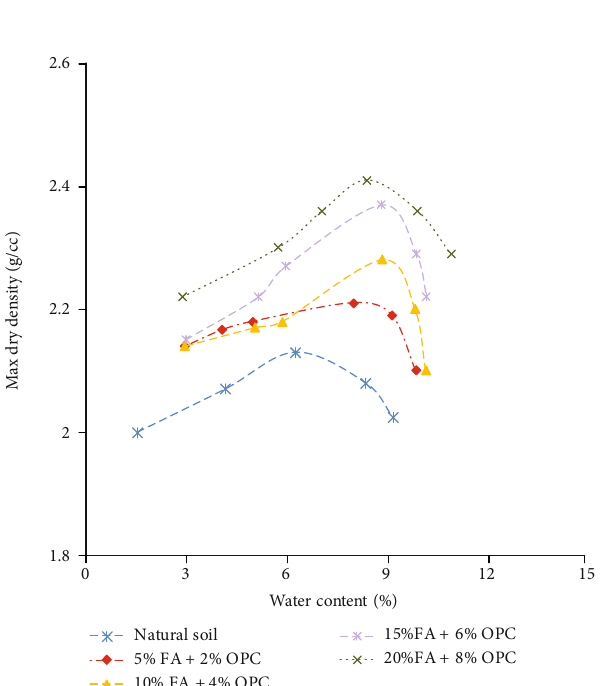
Figure 5: Maximum dry density vs. optimum moisture content for cement and fl y ash mixes.